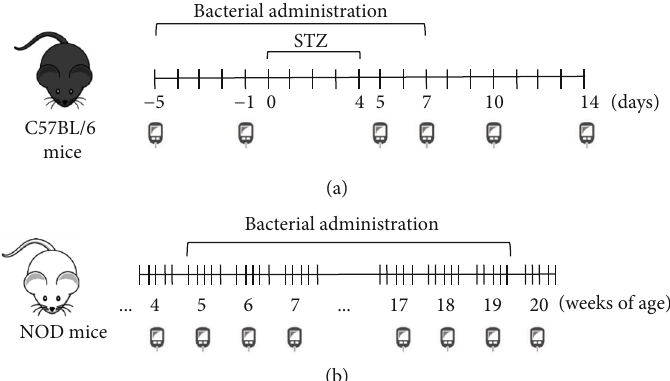
Figure 1: Experimental designs of the STZ-induced and NOD mouse models. (a) Diabetes was induced in male C57BL/6 mice by intraperitoneal injection of STZ+ sodium citrate bu ff er for 5 consecutive days (days 0 – 4). Animals received bacterial administration daily from day -5 to day 7. Blood samples were collected on days -5, -1, 5, 7, 10, and 14 to measure glycemia. Animals were euthanized on day 14 of the experiment. (b) NOD mice received intragastric administration of bacterial suspensions 5 days/week for 15 consecutive weeks. Glycemic levels were measured weekly during the experiment. Animals were euthanized at the end of the 20th